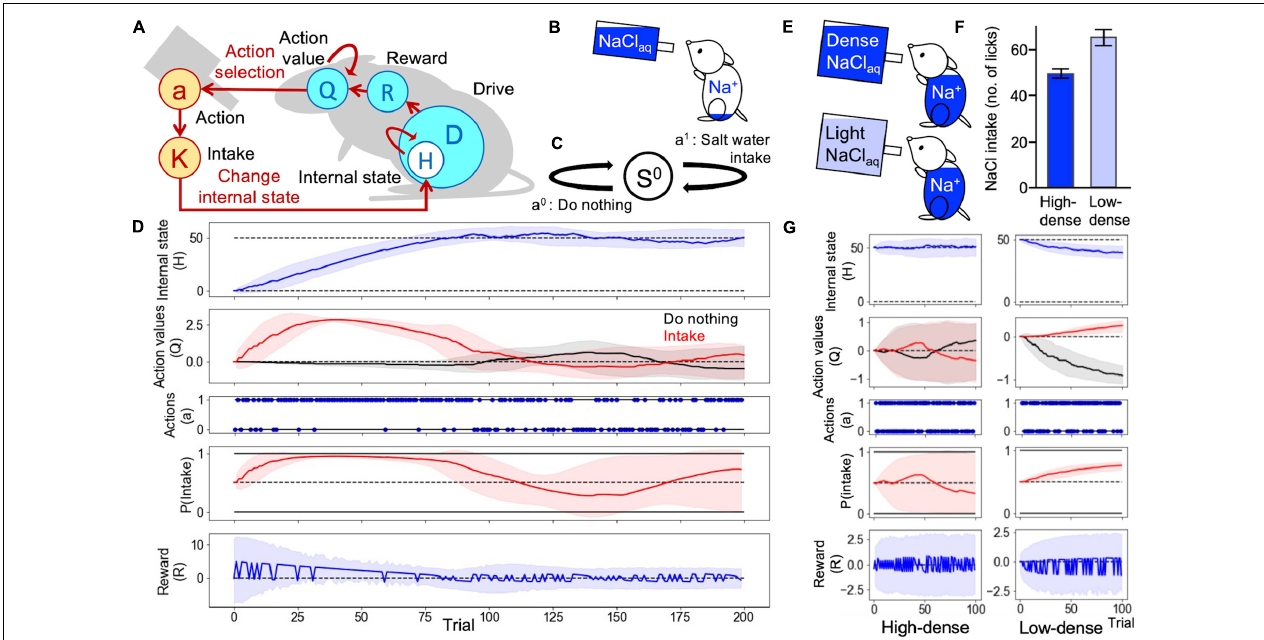
FIGURE 1 | Homeostatic behavior according to the homeostatic reinforcement learning (HRL) model. (A) Schematic drawing of the computational process of the HRL model. (B) In an assumed animal behavior, sodium-depleted mice were able to lick saltwater. (C) Definition of a state and two actions in Simulations 1 and 2. (D) Example of homeostatic behavior. Changes in internal sodium state ( H ), the value of each action ( Q -value), selected actions ( a ), probability of sodium intake [ P ( Intake )], and magnitude of reward ( R ) over time are plotted. The solid lines represent the results of a trial, and the light-colored error ranges represent the mean ± 2 SD of 100 trials. The dotted line in the panel of the internal state indicates the ideal point ( H ∗ = 50) of sodium taste. In the panel related to actions ( a ), action 1 represents “Intake behavior,” and action 0 indicates “do nothing.” At the beginning of the simulation, the internal sodium state and Q -values for each action were set to 0. After several random selections of action, the Q -value of sodium intake was increased, and the internal sodium state quickly reached the ideal point, maintaining homeostatic regulation of behavior. (E) In assumed animal behaviors, a group of sodium-repleted mice was able to lick high-density saltwater, and the other licked low-density. (F) The number of licks of high-density saltwater was fewer than that of low-density. (G) Transitions of each variable over